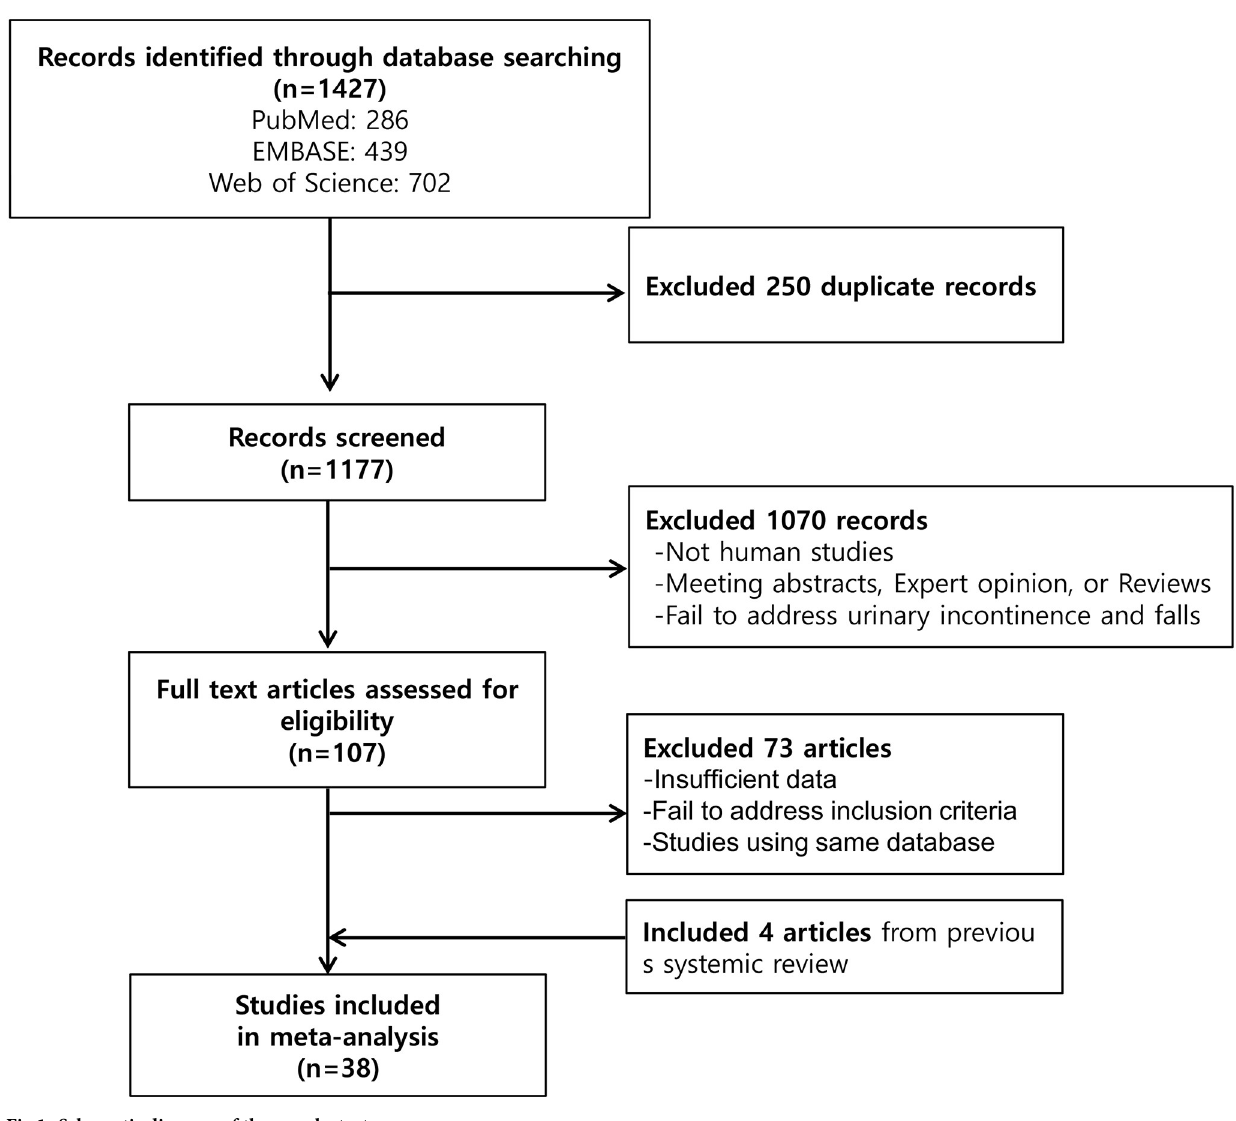
Fig 1. Schematic diagram of the search